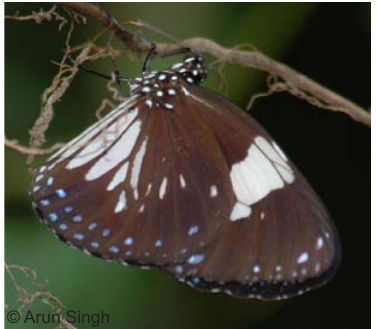
Image 34. Great Nawab Polyura eudamippus